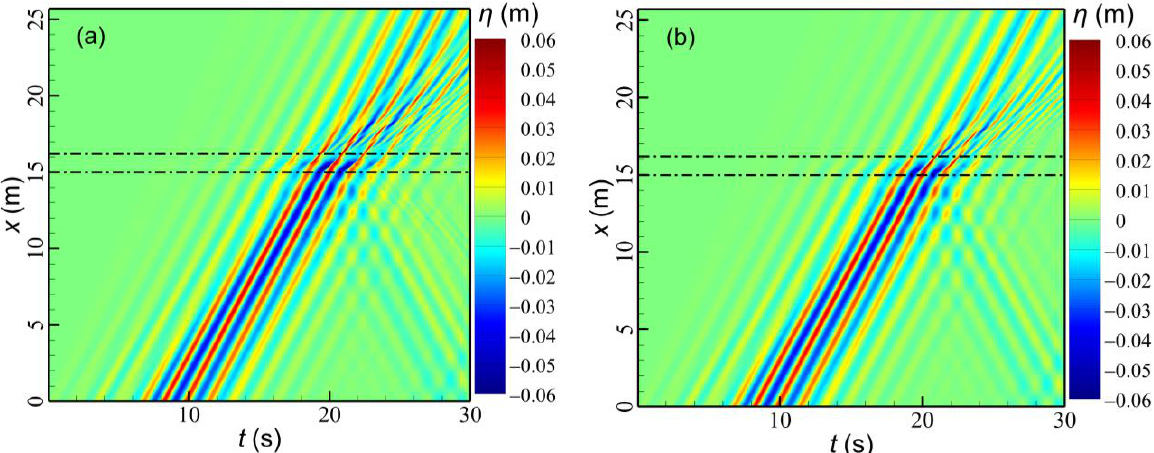
Figure 9. Space – time plots of the water surface elevations of the focused wave groups over the sub- Figure 9. Space–time plots of the water surface elevations of the focused wave groups over the merged breakwaters; left side : submerged impermeable breakwater; right side : submerged perme- submerged breakwaters; ( a ): submerged impermeable breakwater; ( b ): submerged permeable break- able breakwater; dash-dot line: breakwater region. water; dash-dot line: breakwater